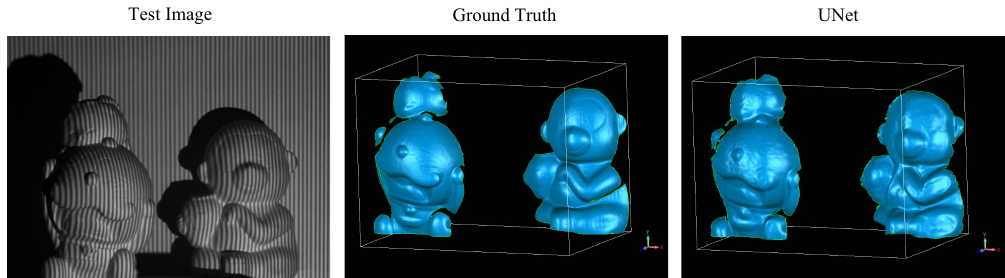
Figure 6. 3D reconstruction results of multiple separated objects.